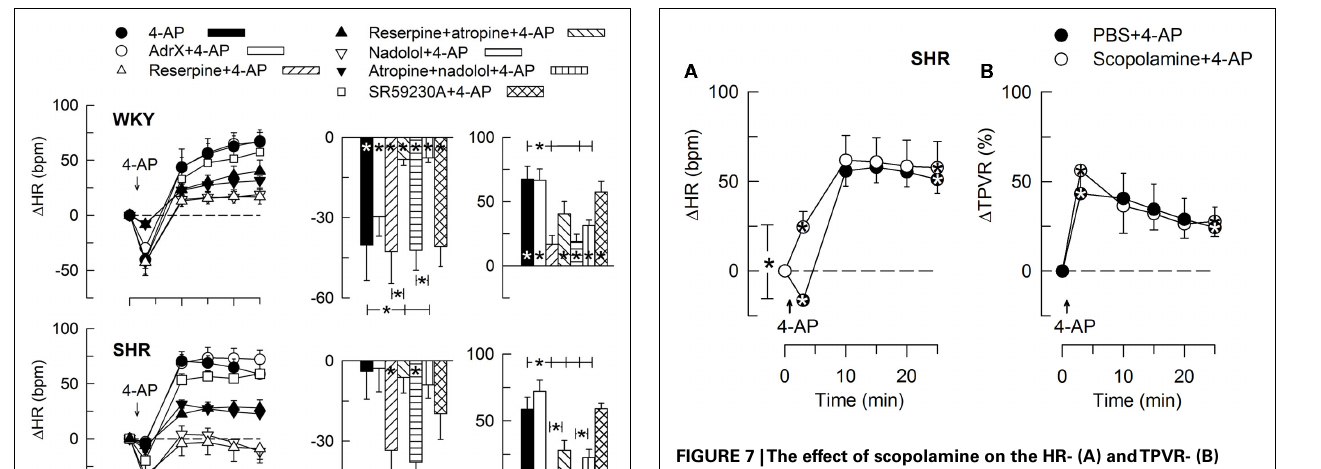
FIGURE 7 |The effect of scopolamine on the HR- (A) andTPVR- (B) response to 4-AP in SHR. Scopolamine had no effect on the MBP-response to 4-AP (not shown).We have previously shown that scopolamine did not significantly alter the response inWKY (Berg, 2002). Significant responses (* within symbol) during the initial response and after 25min, as well as group differences at these times (brackets) were detected as indicated. Scopolamine caused a minor reduction in baseline HR ( Table 2 ). * – P ≤